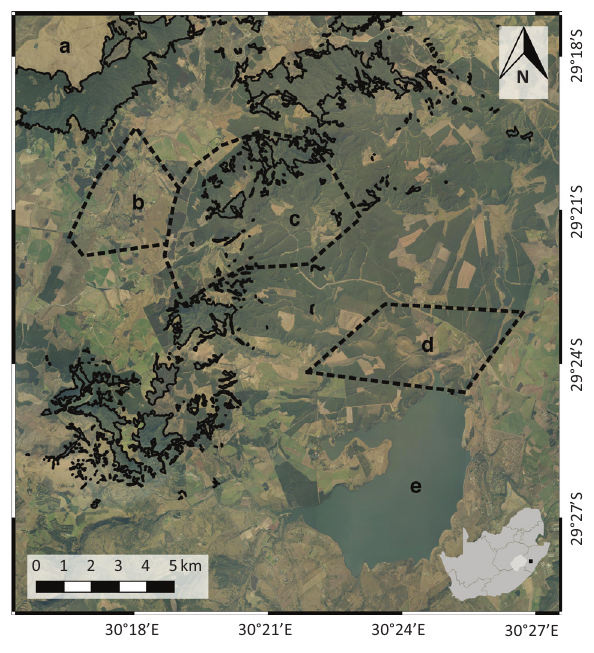
FIGURE 1: The probable type locality of species described by Nylander (1868). A map (Surveyor General’s Office 1904) showing the location of the Armstrong farm – called, at various times, Rod(e)borough, RoodeSpruit, and Amberly (Spencer 1983) – indicates that the farm occupied the upper reaches of a creek draining into the Umgeni River. Dashed lines indicate the approximate boundaries of relevant farms circa 1904. Solid black lines indicate present-day extent of forest cover (South African National Biodiversity Institute 2012). (a) Karkloof Nature Reserve (present day). (b) Farm occupied by Trotter family. (c) Farm occupied by Armstrong family. (d) Farm occupied by Mackenzie family. (e) Reservoir of Albert Falls Dam (present